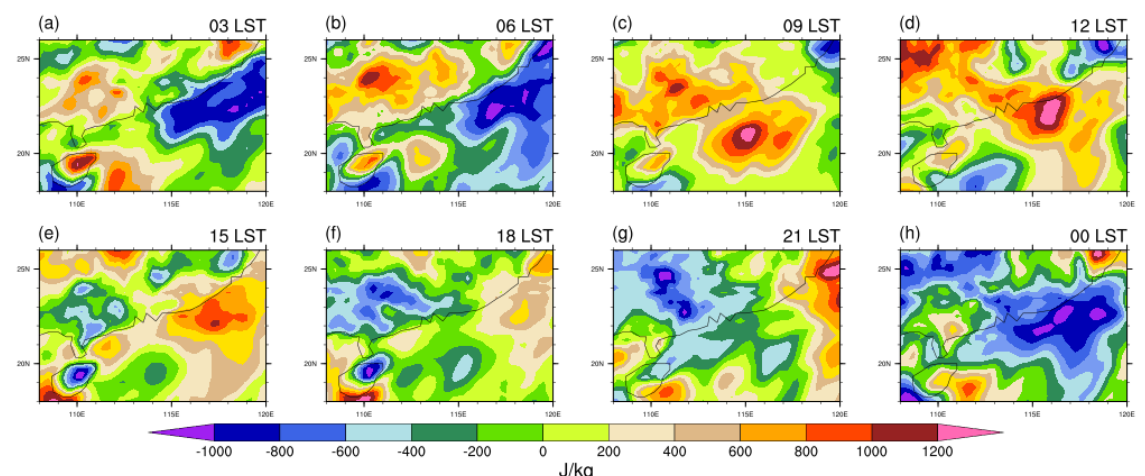
Figure 13h. This spatial pattern of convective instability further supports the migration or initiation of strong MCSs over the offshore region at ~03 LST.